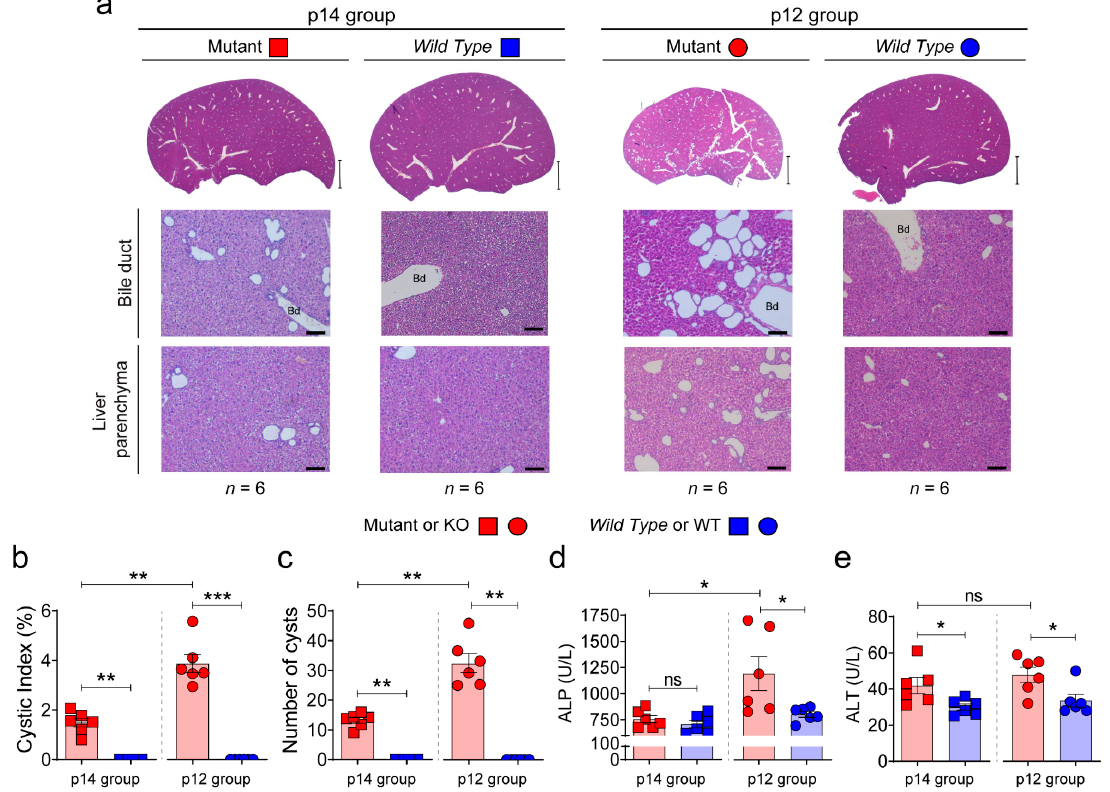
Figure 1. Characterization of the cystic liver phenotype at day 30 form p12 and p14 stages. Pkd1 deletion at p12 carries a more severe cystogenesis. ( a ) Representative macroscopic and microscopic images of hematoxylin–eosin stained from livers of Pkd1 cond/cond ;Tam ‐ Cre mouse Wild Type (WT, Pkd1 cond/cond ;Tam ‐ Cre ‐ ) and Mutant (KO, Pkd1 cond/cond ;Tam ‐ Cre + ) with Pkd1 gene deletion induced by tamoxifen at postnatal day 14 (p14 group) and 12 (p12 group). All mice were sacrificed at p30. Scale bar, 2 mm (upper panel) 100 μ m (lower panel). n represents the number of samples per group, and Bd means bile duct. ( b , c ) Hepatic cystic index and number of cysts of the different phenotypes. ( d , e ) Blood serum ALP and ALT values. Bars represent means ± SEM in all cases. p < 0.05 by Student’s t -test (two-tail) was considered as a significant result. ns represents not significance. * p < 0.05, ** p < 0.01, *** p <